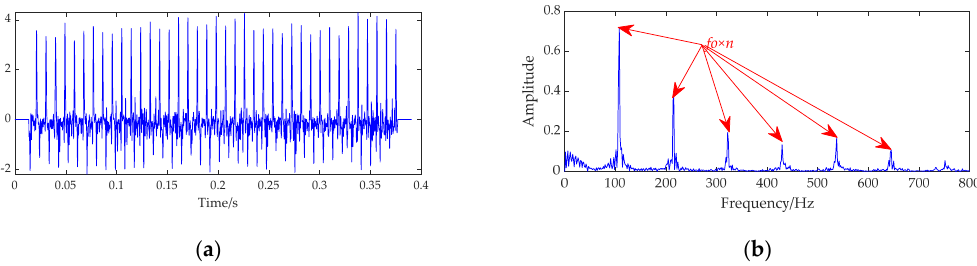
Figure 15. Outer ring fault signal. ( a ) Time-domain waveform using CLNGO-MNAD. ( b ) Envelope spectrum of using CLNGO-MNAD.